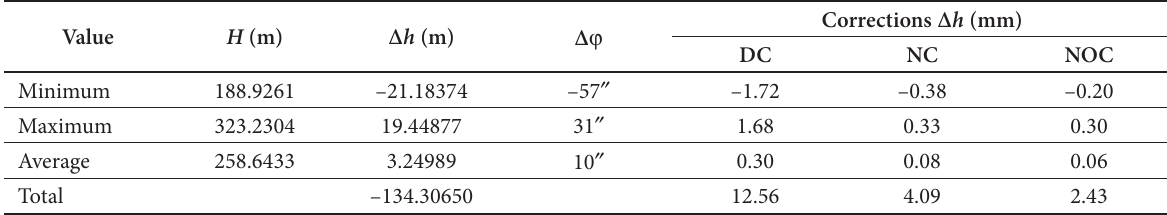
Table 5. Values of known and calculated